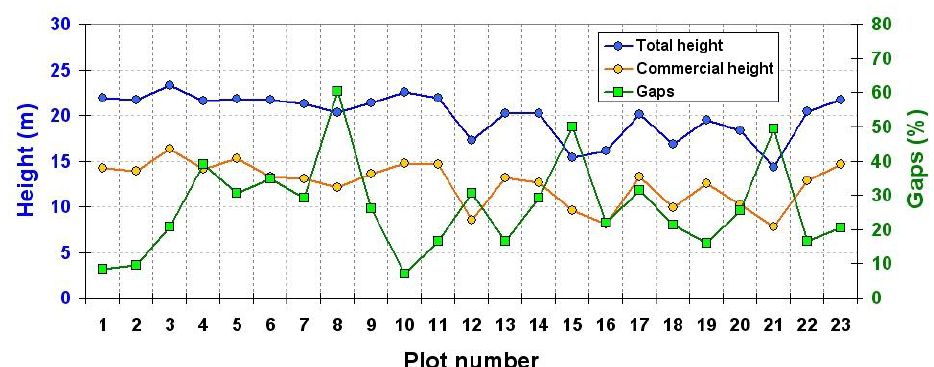
Figure 4. Tree heights.